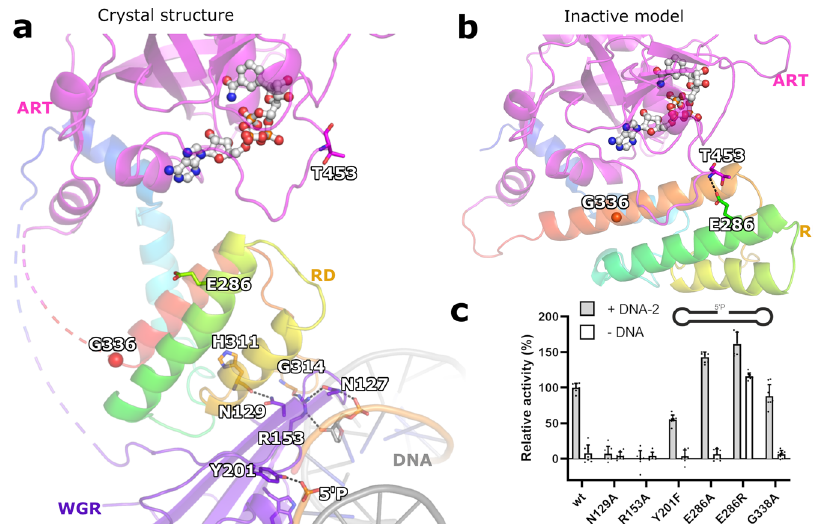
Fig. 4 PARP2 activation mechanism. a Upon DNA binding the interactions formed by Arg153, Asn127 and Asn129 transmit the signal for the conformational change to release the RD – ART interaction. b A model of a PARP2 binding to DNA in an inactive conformation showing the interaction between the RD and ART domains in the inactive conformation. c DNA-dependent activity assay measuring NAD + consumption (used at 5 µ M concentration) after incubation with PARP2 enzymes (50 nM). Points correspond to conversion of 8 individual data points obtained from 2 independent experiments. Bars correspond to average and error bars to SD. Source data are provided as a Source Data fi le.